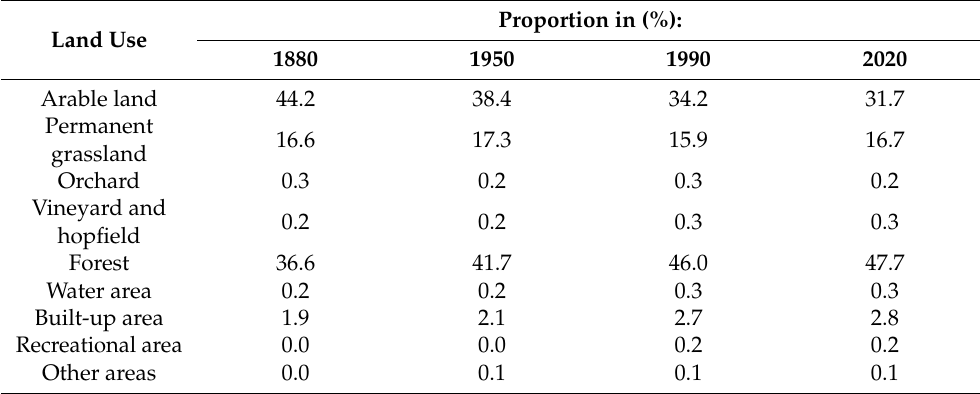
Table 3. The proportion of the land use categories in the planned water reservoirs and their surround- ings over four periods